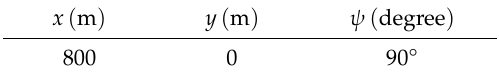
Table 6. Initial AUSV conditions (continuous